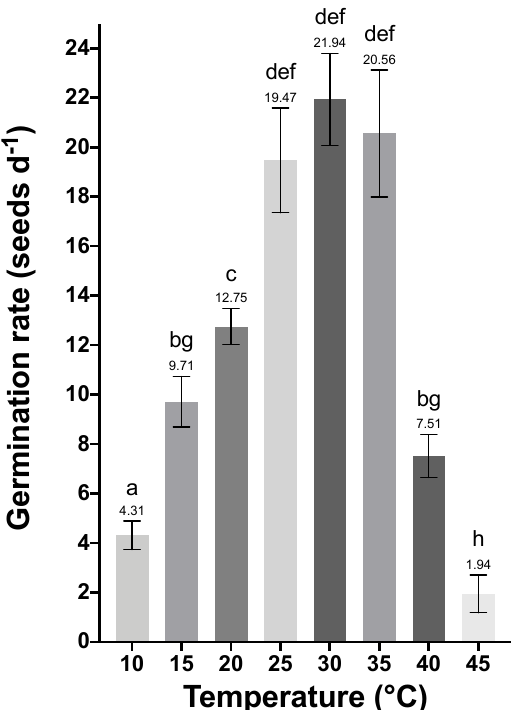
Figure 2. Germination rate per day of seeds at 10–45 °C. Values are shown as means ± SD of five replicates with 25 seeds each. Values are expressed as mean ± SD of five independent replicates. Statistical analysis was performed using Kruskal-Wallis followed by a Dunn’s multiple comparison test. Different letters indicate significant differences.